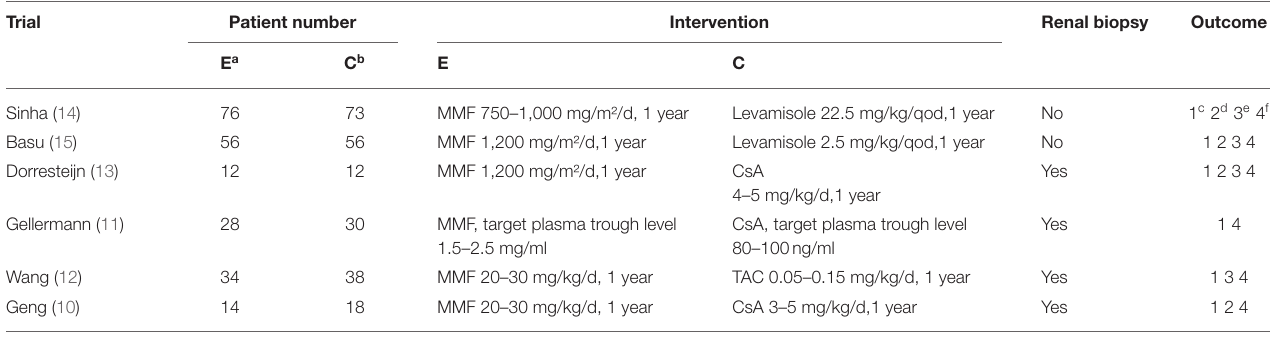
TABLE 1 | Characteristics of the included study.